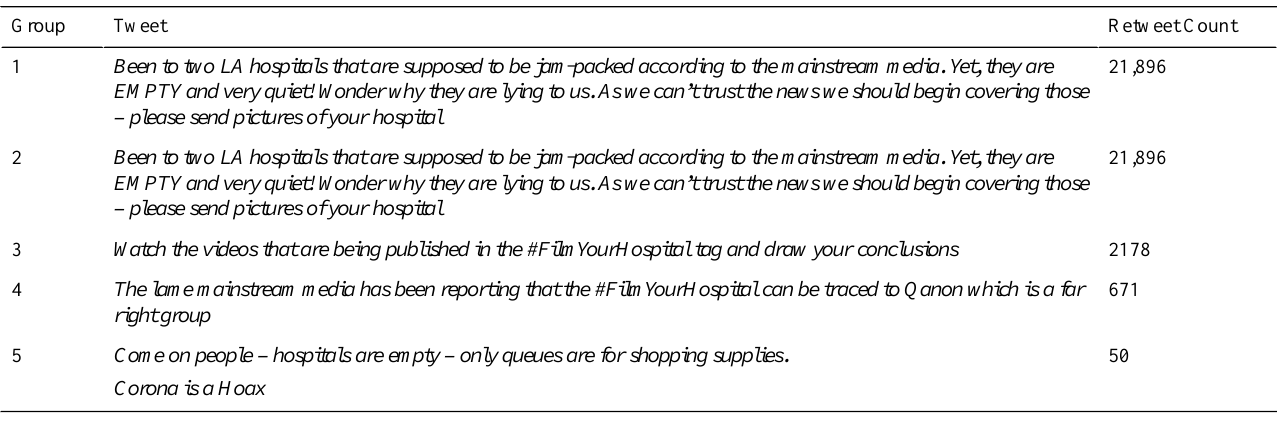
Table 1. Most retweeted tweets in groups 1 to 5.